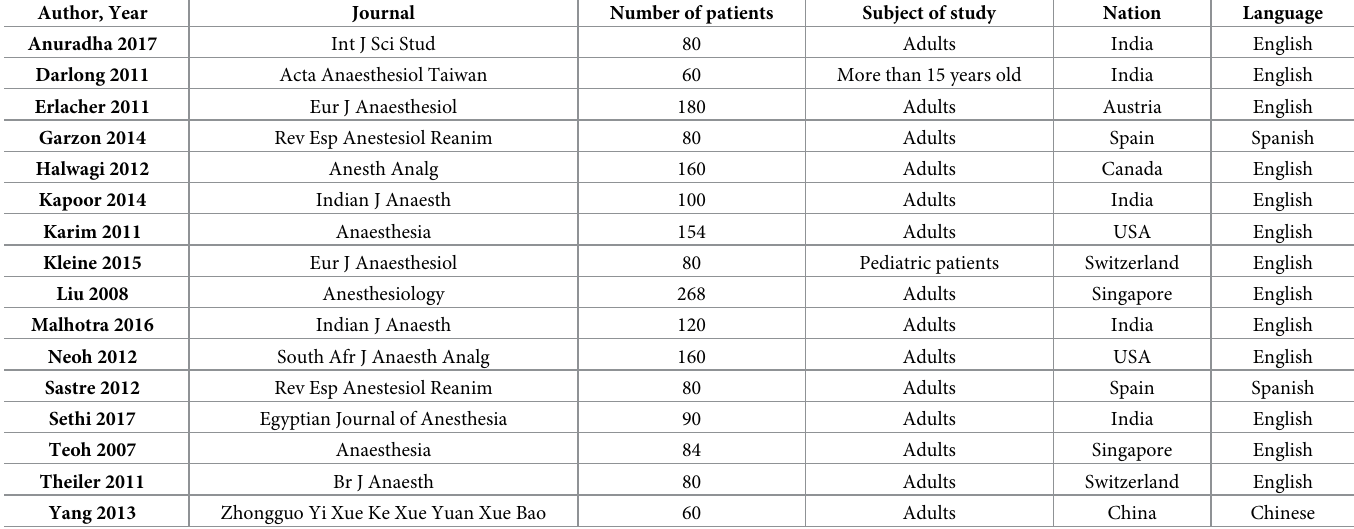
Table 1. Baseline characteristics of the included randomized controlled